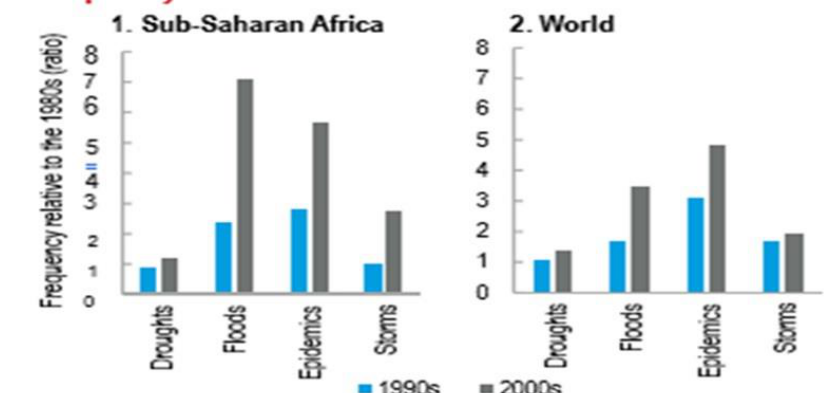
Fig. 1. Sub-Saharan Africa (1) and the World (2): Frequency of Natural Disasters Relative to the